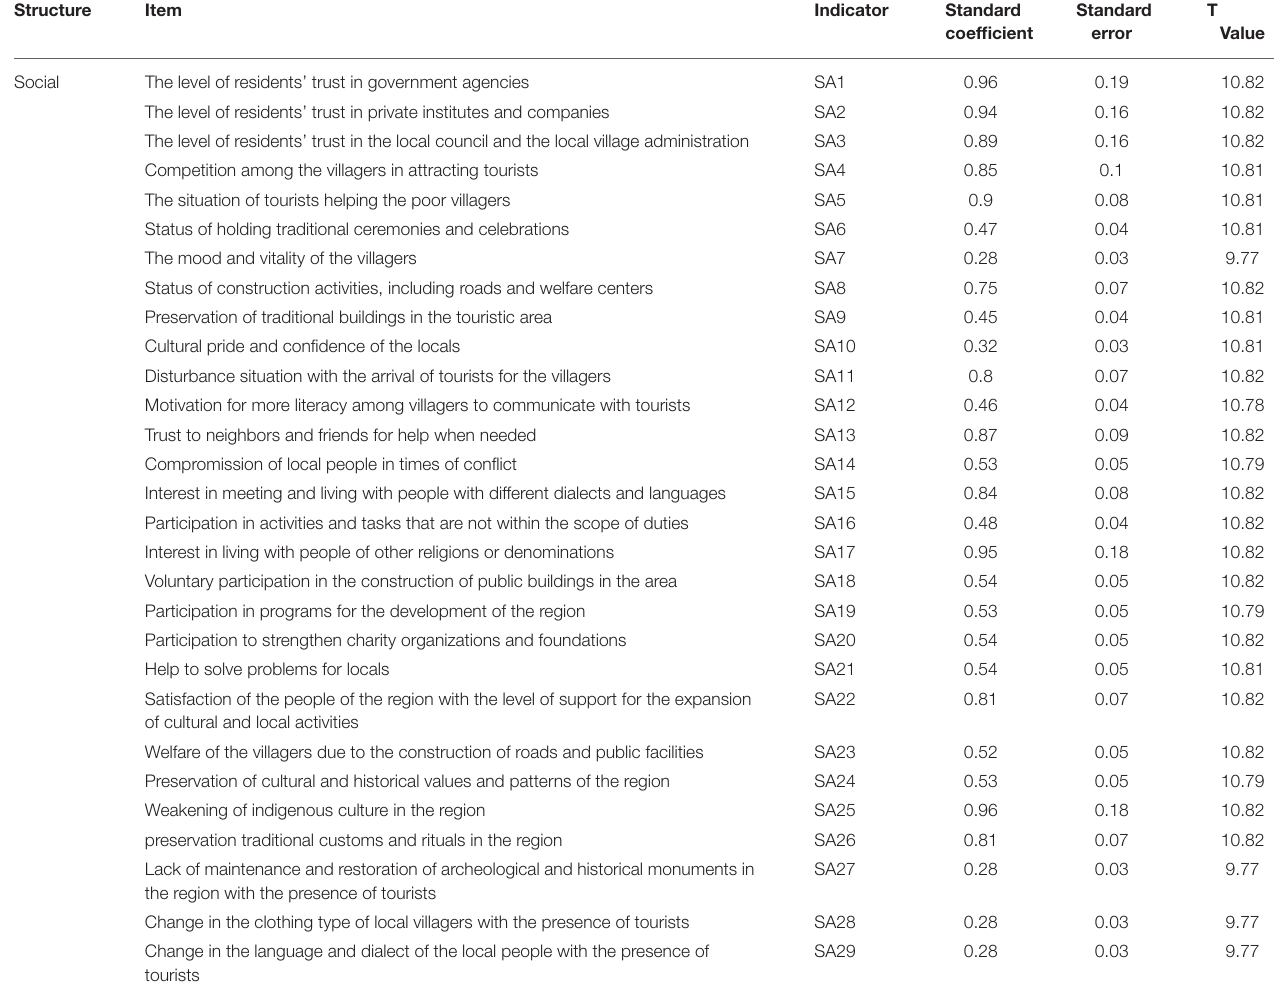
TABLE 2 | Summary of results obtaine+d from the social effects model (second-order confirmatory factor analysis). Structure Item